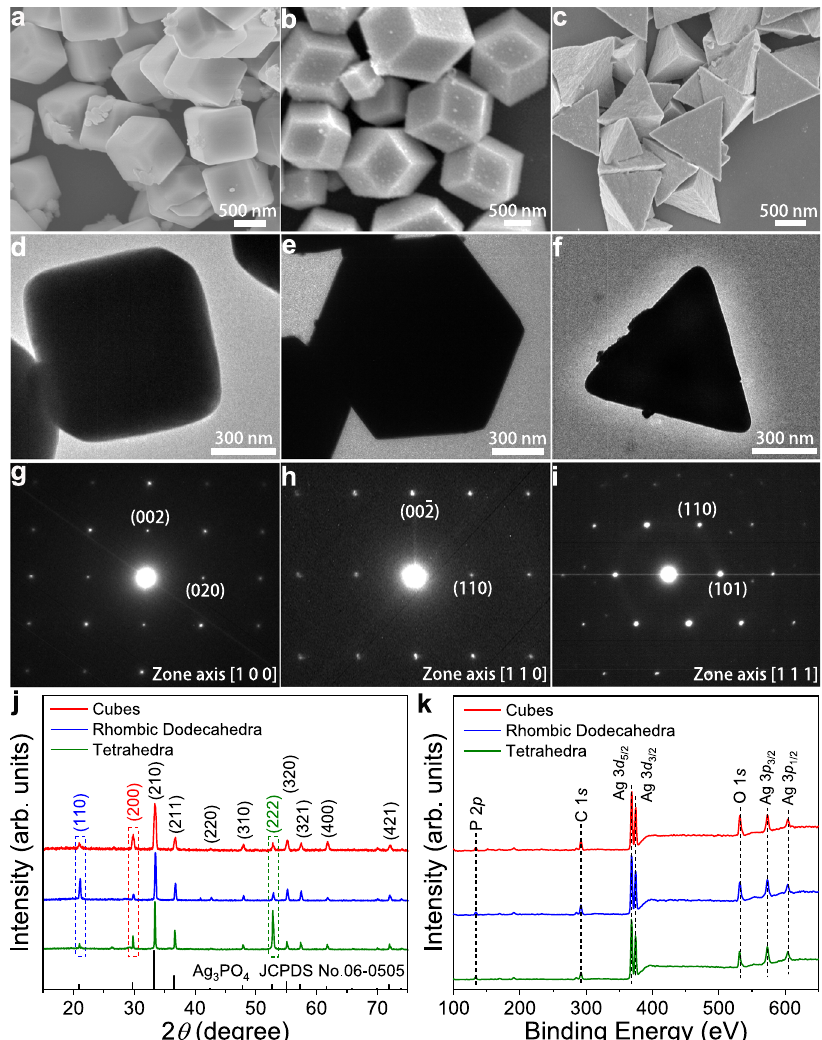
Fig. 1 Structural characterizations of Ag 3 PO 4 crystals. a – c SEM images of Ag 3 PO 4 cubes ( a ), rhombic dodecahedra ( b ), and tetrahedra ( c ). d – f TEM images of a Ag 3 PO 4 cube ( d ), rhombic dodecahedron ( e ), and tetrahedron ( f ). g – i SAED images of a Ag 3 PO 4 cube ( g ), rhombic dodecahedron ( h ), and tetrahedron ( i ). j , k XRD patterns ( j ) and survey XPS spectra ( k ) of Ag 3 PO 4 cubes, rhombic dodecahedra, and